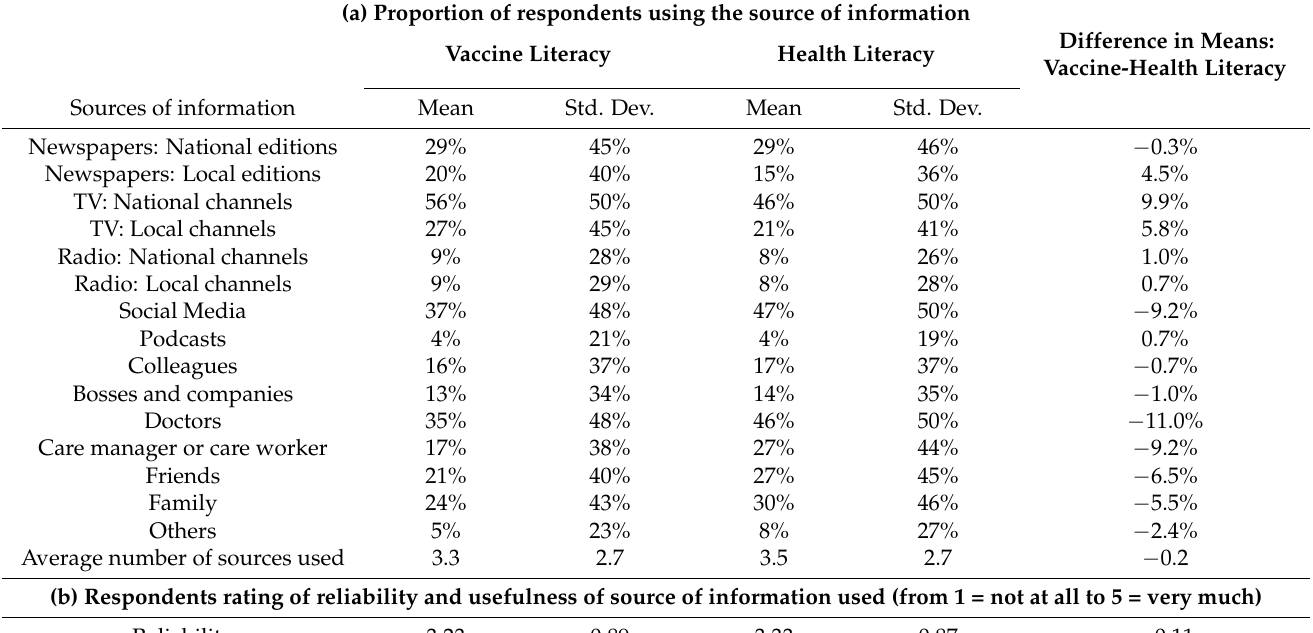
Table 2. Sources of information used to inform vaccine and health